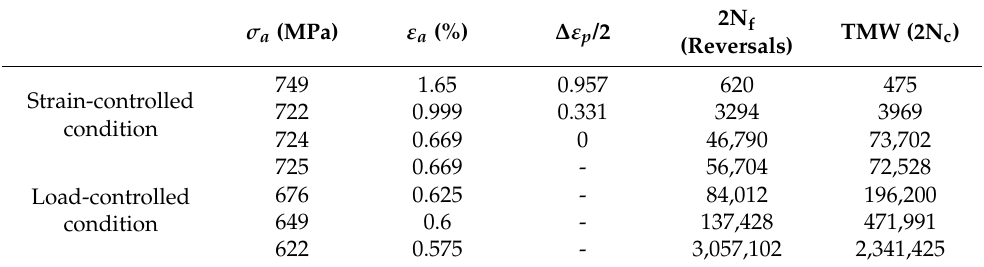
Table 7. Fatigue test results of wrought Ti-6Al-4V with the machined surface under axial loading (test information and data taken from [21]).